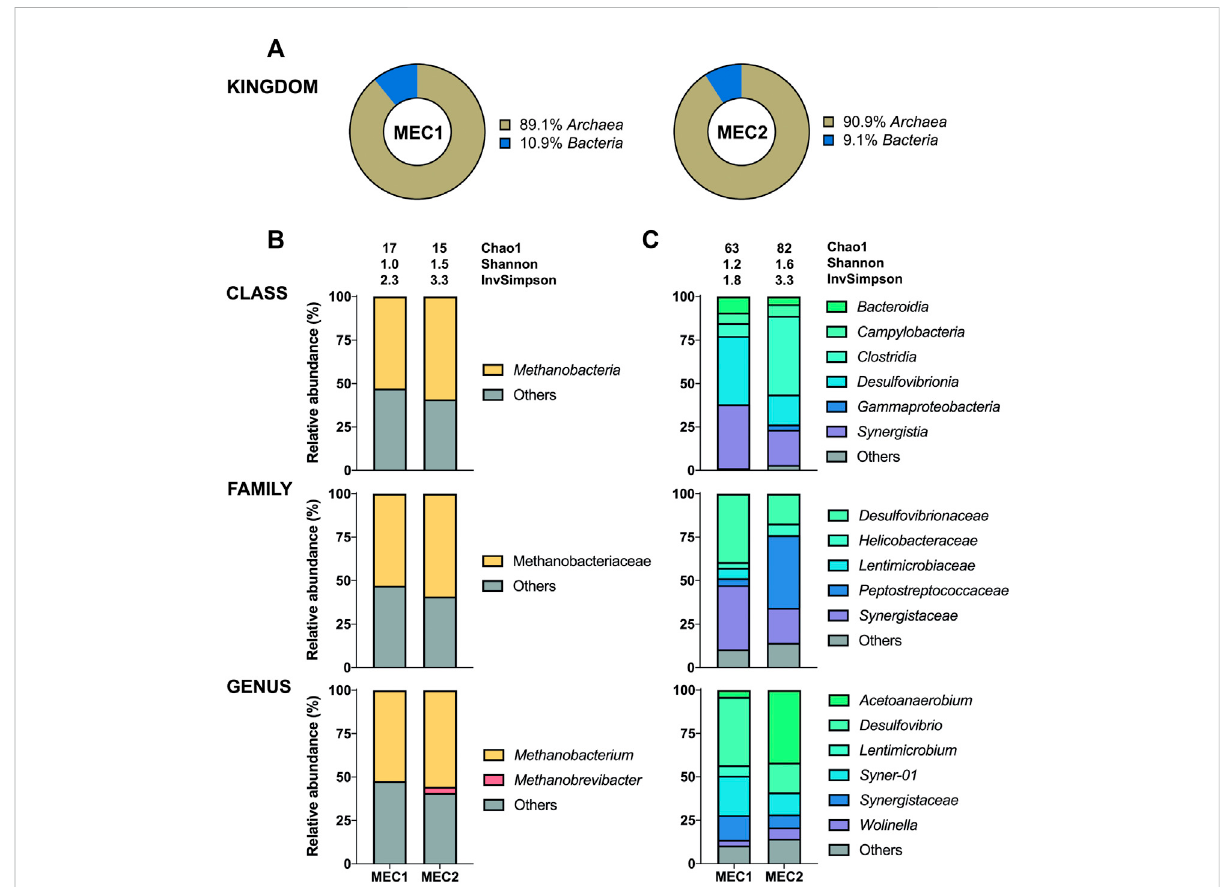
FIGURE 6 The enriched microbial communities of cathodic bio fi lm in MECs. (A) Representation of prokaryotes determined by the 16S sequencing. Taxonomic pro fi les of bacteria (C) and methanogenic archaea (B) were set at the class, family, and genus ranks. Bacterial representation was determined by the 16S sequencing and methanogenic archaea by the mcrA sequencing. Only representatives with a relative abundance > 3% in at least one condition are shown. Alpha diversity was estimated by the following indices: Chao1, Shannon, and Inverse Simpson. Detailed information is given in Supplementary Table